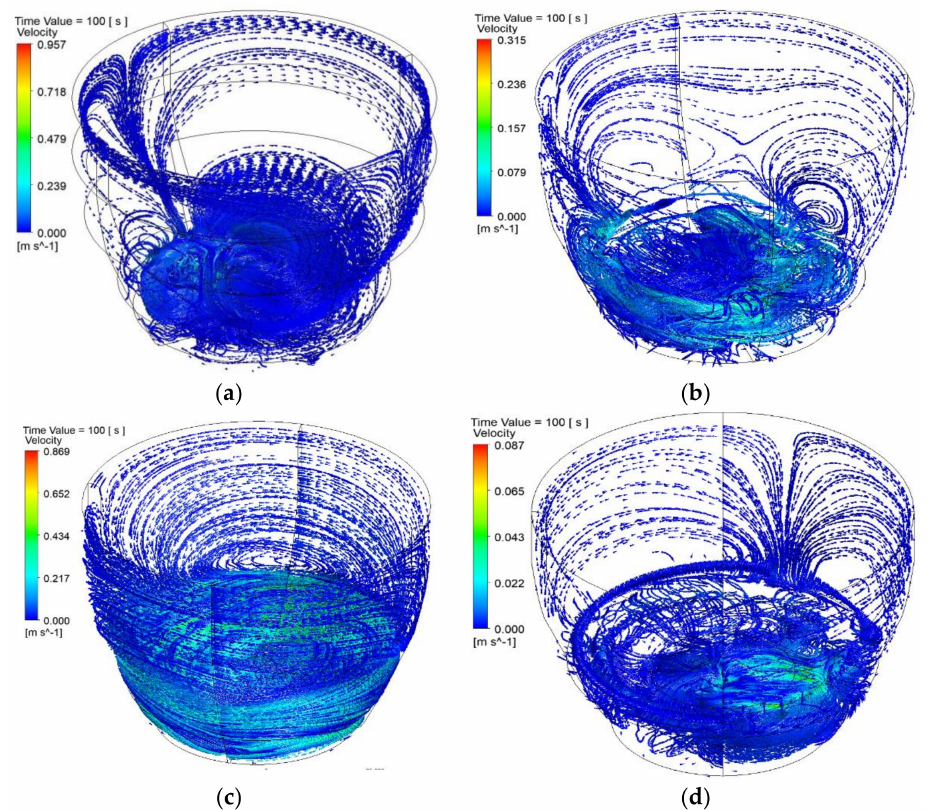
Figure 18. 3D Streamline with the velocity vector, Model 1. ( a ) VF = 10%, Q = 10 W. ( b ) VF = 30%,